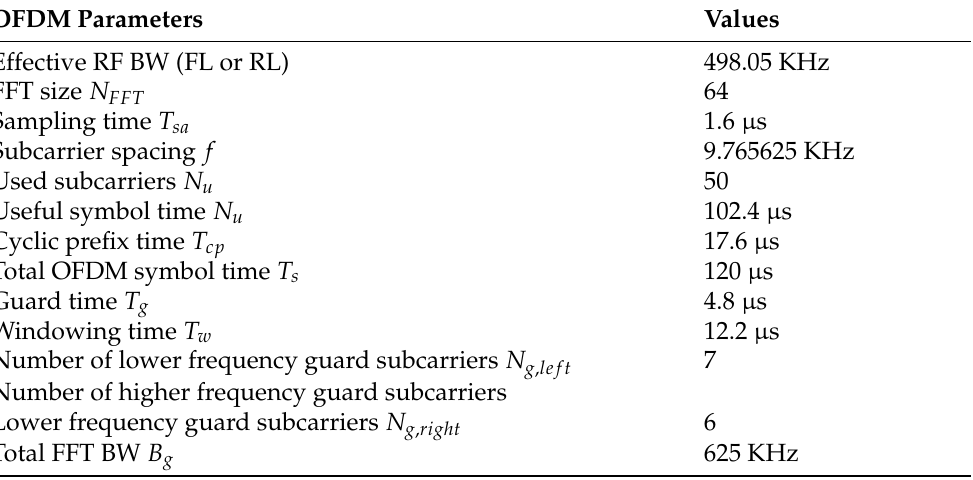
Figure 27. Performance of ROADPB vs. pulse blanking, GAE and OBE enhanced pulse processors. Table 1. OFDM Parameters for LDACS1